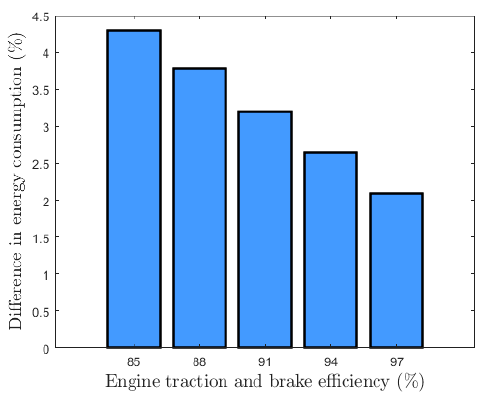
Figure 6. Difference in energy consumption at the pantograph (in %) between the considered driving strategies for different values of the engine traction and brake efficiency in Calatayud–Zaragoza section.